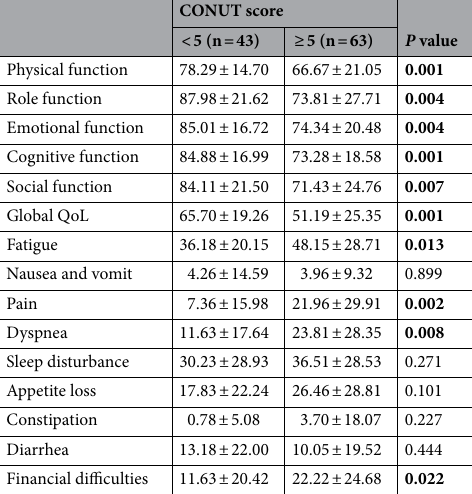
Table 10. Analysis of the relationship between CONUT and postoperative QoL.